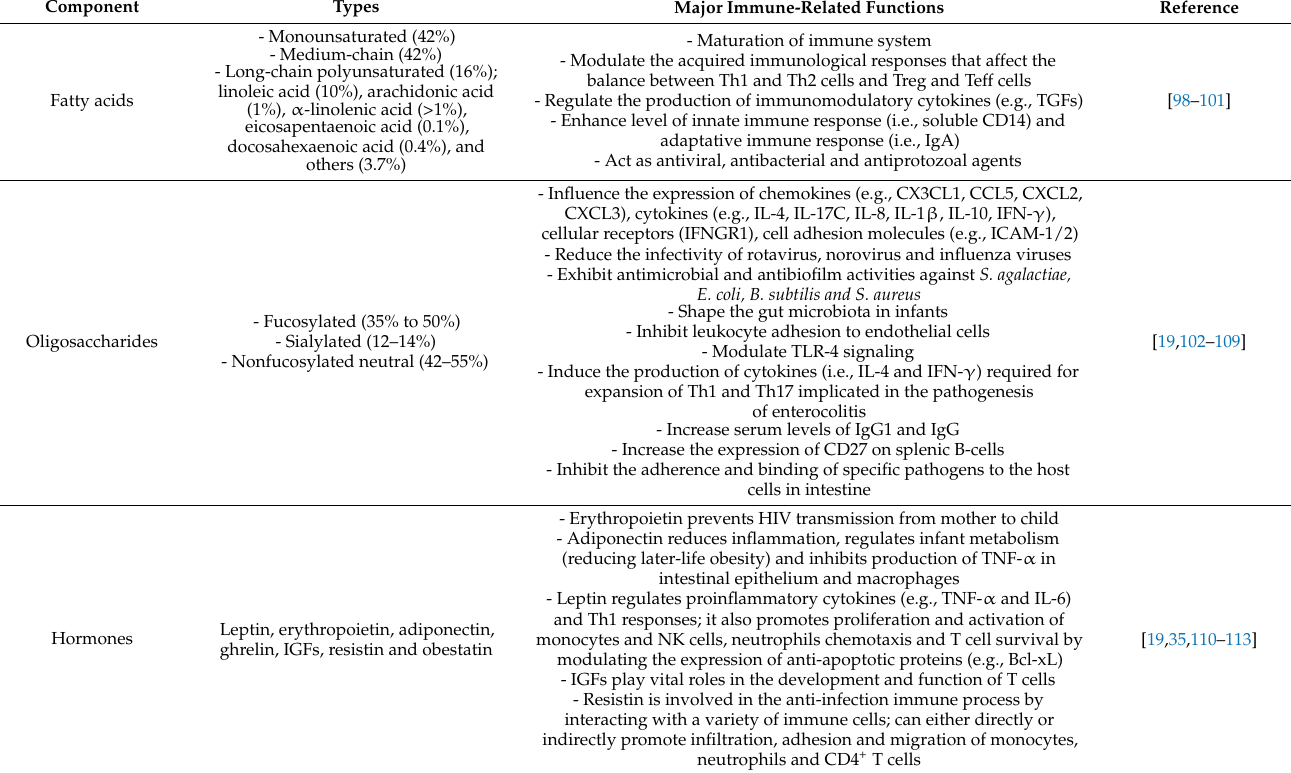
Table 1. The main immunomodulators in HBM and their roles in improving the health and im- mune